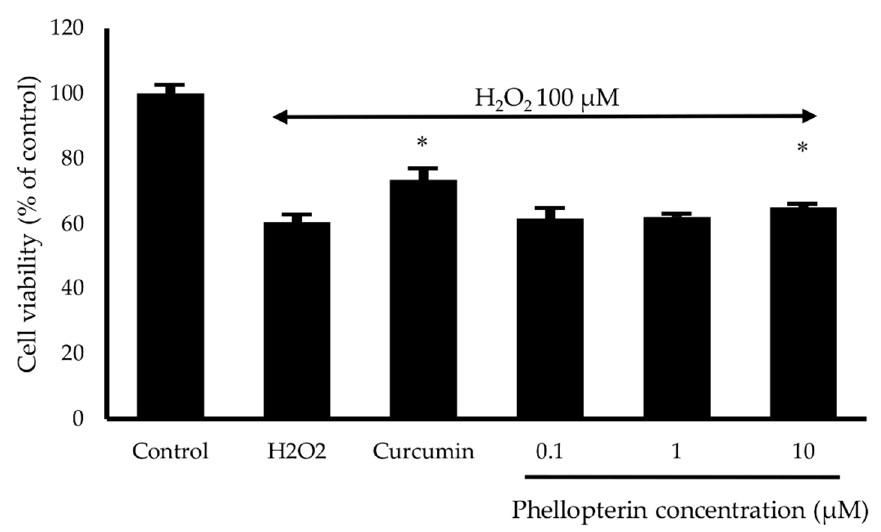
Figure 5. Effects of phellopterin on H 2 O 2 -induced cell damage in SH-SY5Y cells. Curcumin at 10 µM was used as a reference standard. The values are reported as mean ± SD ( n = 3). Paired t-test, * p < 0.05 versus H 2 O 2 treated group.